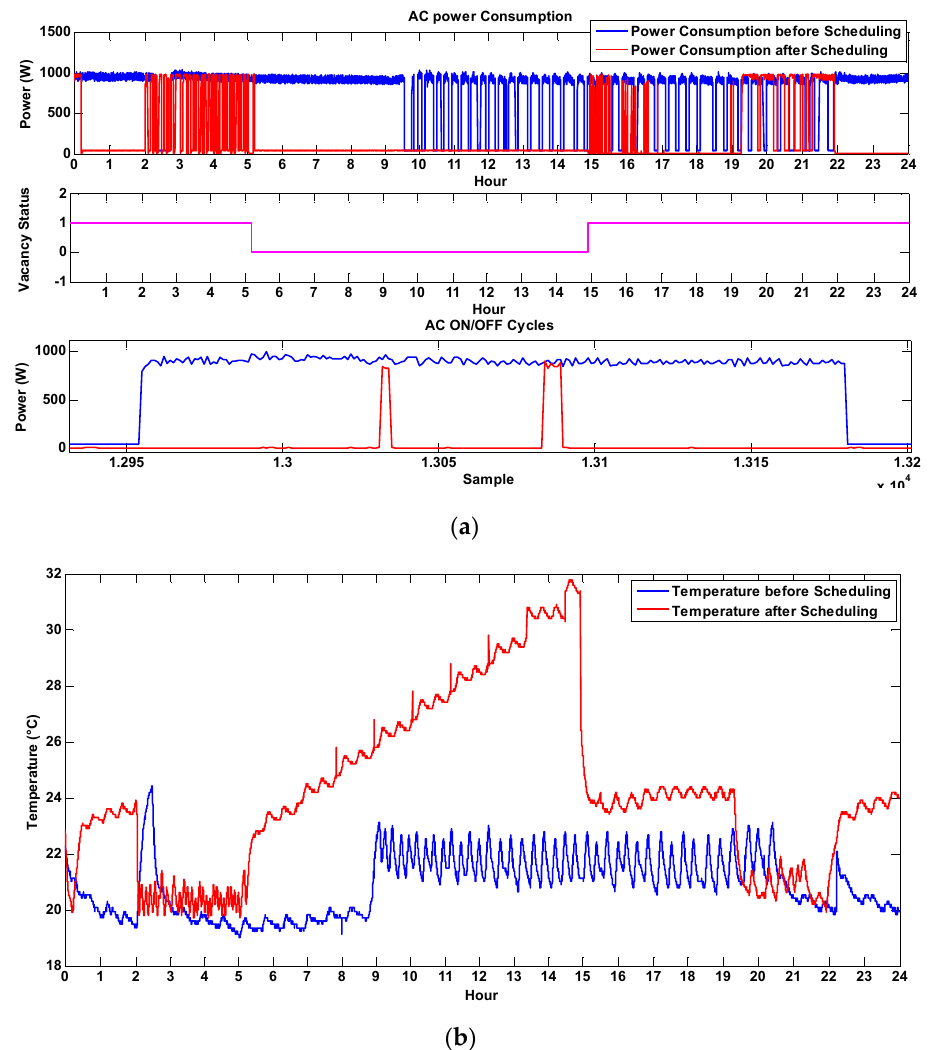
Figure 19. ( a ) Power consumptions of the AC, room occupancy statuses, on/off cycles of the AC and ( b ) room temperature variations without and with the use of the HEM system.